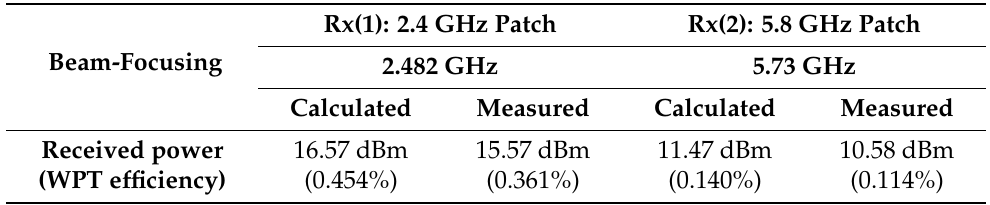
Table 5. Experimental result of the dual-band received power when transmitting a dual beam separately to two receiving antennas.